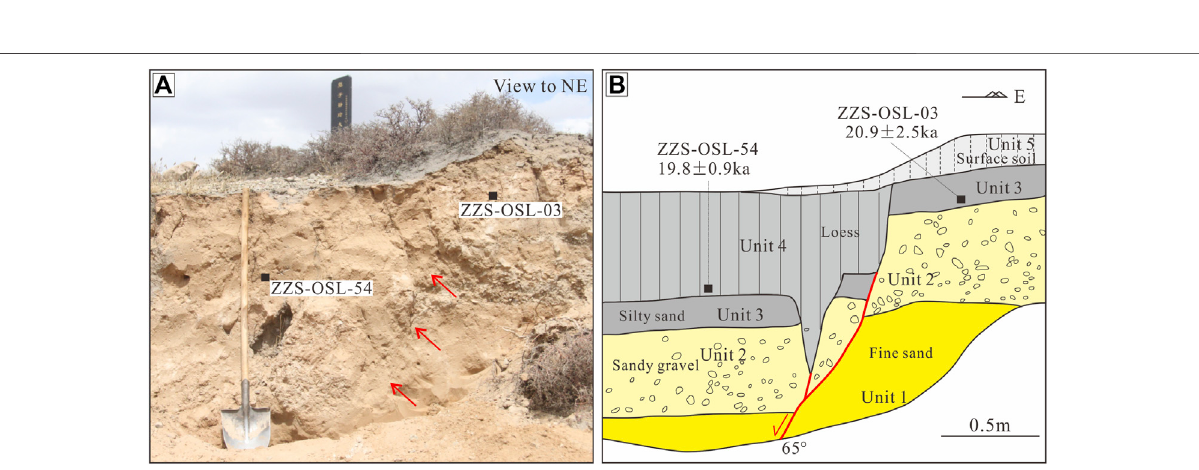
FIGURE4|(A) Faultoutcropunderneaththescarp.Thelocationofthefaultplaneismarkedwithredarrows (B) thecorrespondingsketchattheLingyuansite.One majornormalfaultisprominent,displacingsedimentaryUnits1 – 4.TwoOSLsamples(ZZS-OSL-03andZZS-OSL-54)collectedfromthefaultedandcoveringunitswere dated, yielding ages of 20.9 ± 2.5 ka and 19.8 ± 0.9 ka, respectively (Table 1)